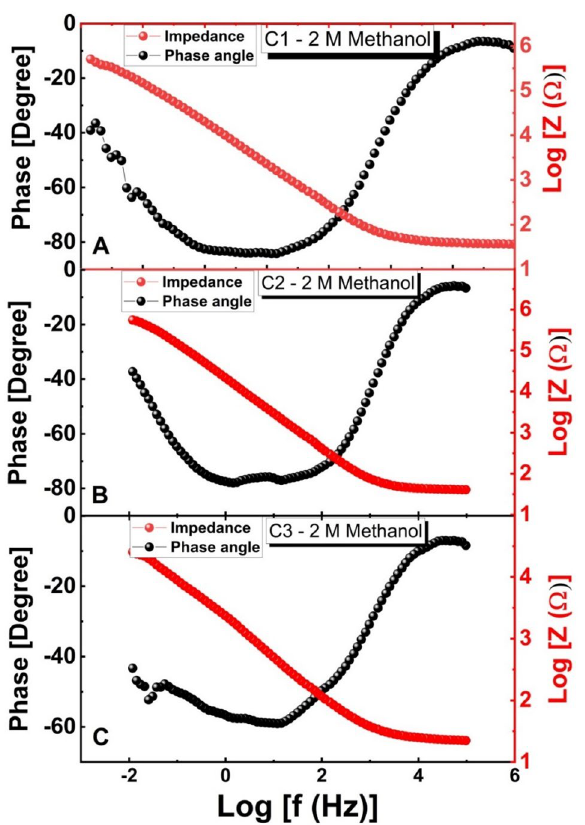
Figure 14. ( A – C ). Bode plots for electrodes C1, C2, and C3 in methanol at the optimized concentrations and 0 V (vs.